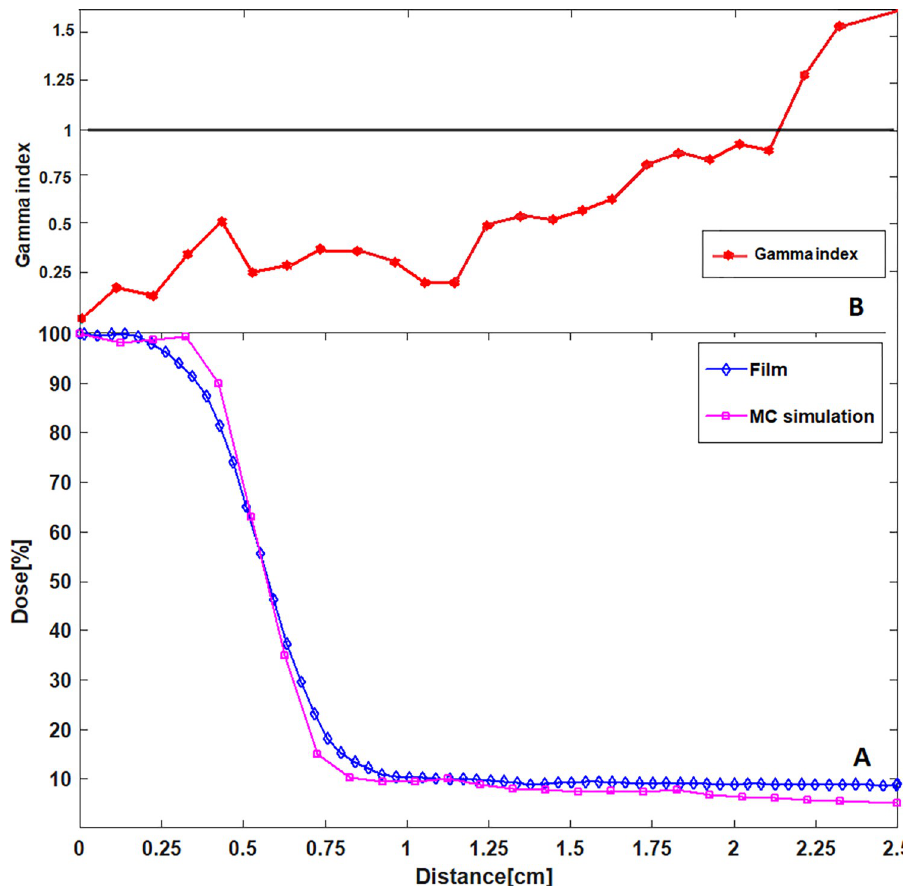
Fig 5. Measured and calculated dose profiles. A) The blue line is the dose profile sampled measured across PMMA tumour phantom exposure. The purple line is the corresponding calculated dose profile results from the EGSnrc simulation, B) The cyan line shows the resultant gamma index trend determined between the two relative GAFchromic film measurements and EGSnrc calculation dose